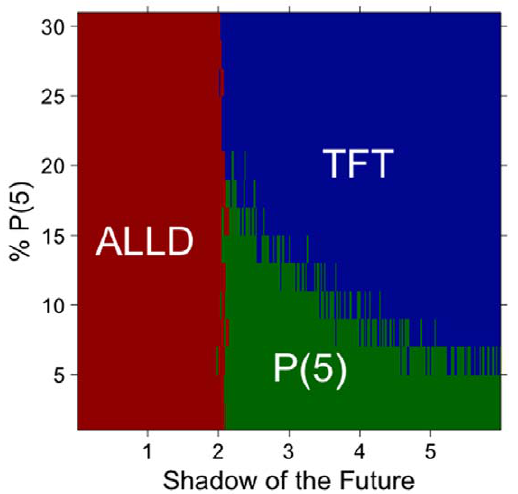
Figure 4. Strategies with the highest average score, as a function of the proportion of prejudiced players. Each individual is given five traits; the proportion of prejudiced (P(5)) players added to the simulation is ‘‘% P(5)’’, with the remaining population equally split between ALLD and TFT players. For short shadows of the future, ALLD defeats all other strategies. For longer shadows of the future, prejudiced players can beat TFT, but only if the total proportion of prejudiced players in the population remains sufficiently low. In other words, prejudiced strategies perform well against TFT and ALLD, but not against